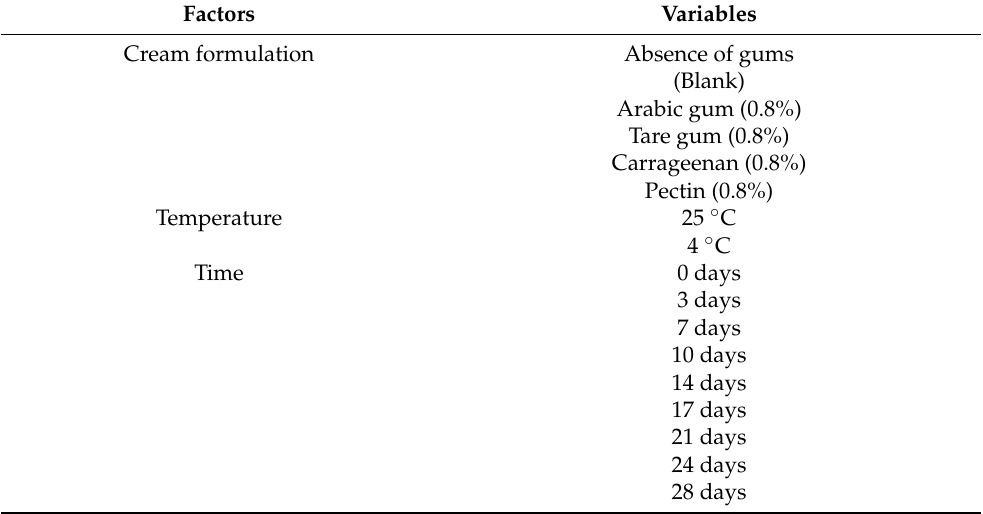
Table 1. Research factors and